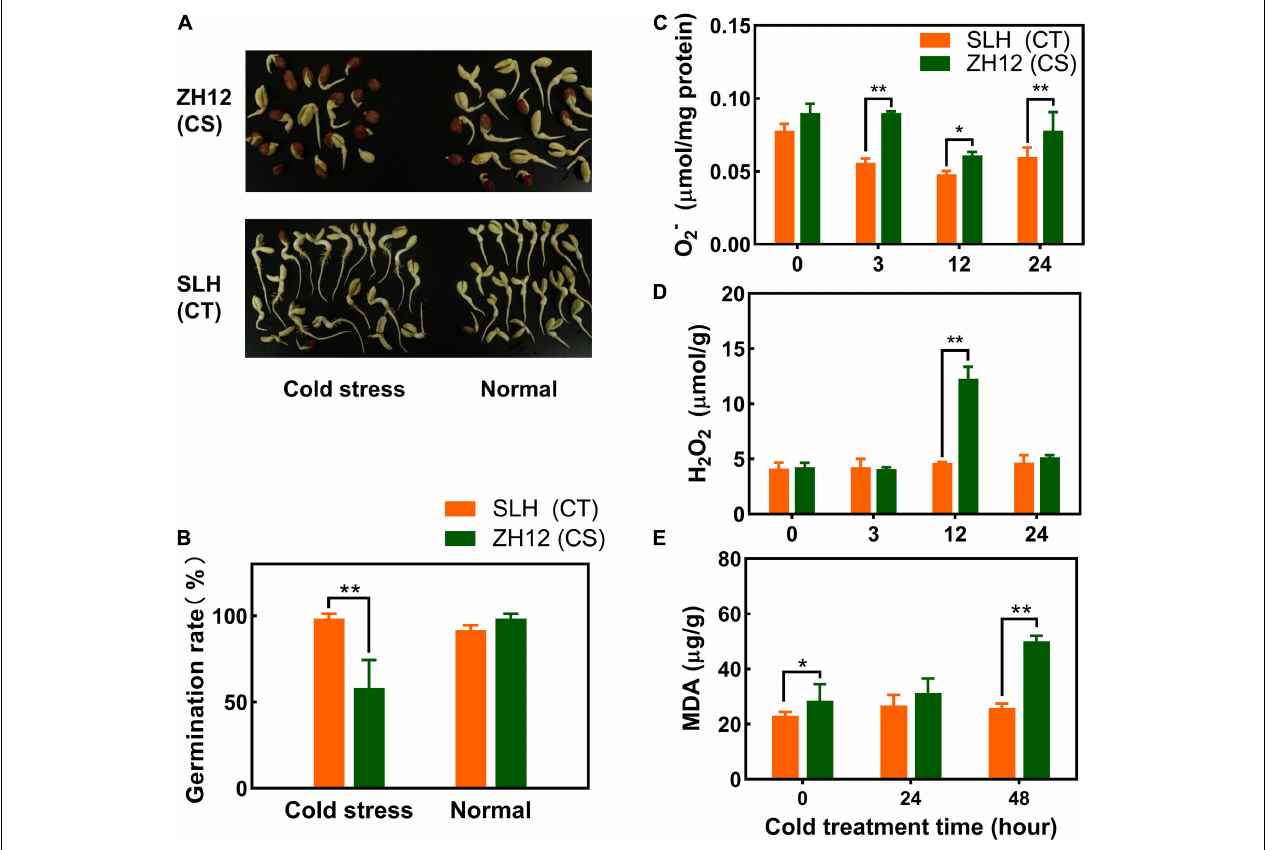
FIGURE 1 | Differential physiological responses of SLH and ZH12 peanut cultivars to cold stress. (A,B) Effects of low temperature on germination rates of the two peanut cultivars. For cold treatment, seeds were immersed in distilled water for 4 h, and then transferred to petri dishes at 2 ◦ C for 72 h in the dark, and, finally, returned to normal temperature (28 ◦ C) for additional 3 days for germination. The controls were continuously germinated at 28 ◦ C for 3 days. SLH (CT), the cold-tolerance cultivar; ZH12 (CS), the cold-susceptible cultivar. The level of O 2 - (C) , H 2 O 2 (D) , and malondialdehyde [MDA, (E) ] of peanut seedlings in response to chilling stress. Error bars represent the SD of the means of three biological replications. *An asterisk indicates significant difference between the two cultivars as determined by the Student’s T- test (* p < 0.05; ** p < 0.01).